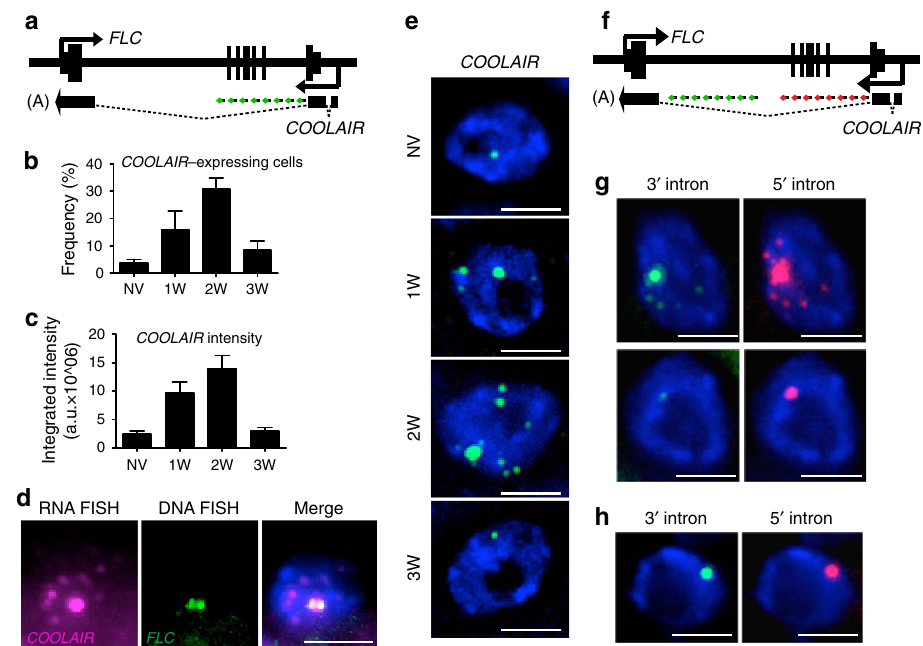
Figure 2 | COOLAIR transcription rapidly increases in some cells in the cold and coats the locus. ( a ) Schematic of the probes used to detect COOLAIR non-spliced transcripts. ( b ) Frequency of cells showing COOLAIR signals with increasing cold exposure (non-vernalized (NV), 1W, 2W, 3W). Error bars are þ / (cid:2) s.e.m., with N ¼ 250 cells. ( c ) Quantification of total integrated intensity of the large COOLAIR foci at different time points with increasing cold exposure. Error bars are þ / (cid:2) s.e.m., with N ¼ 60 cells. ( d ) Representative image of a nucleus showing co-localization of COOLAIR non-spliced RNA smFISH signals (magenta) with FLC DNA FISH signals (green). ( e ) Representative images of nuclei hybridized with COOLAIR smFISH probes (green), depicted in a , in NVand plants exposed to different weeks of cold (1W, 2W, 3W). The data show the increase in the number and intensity of COOLAIR foci per nucleus. ( f ) Schematic of the probes used to detect the 5 0 (red) and 3 0 (green) end of COOLAIR largest intron. ( g ) Representative images of nuclei showing higher signals at the 5 0 -end, in plants exposed to 2-weeks of cold. ( h ) Representative image of a nucleus showing equally high signals at the 5 0 and 3 0 end, in plants exposed to 2-weeks of cold. DNA labelled with DAPI (blue). Scale bar, 5 m m.